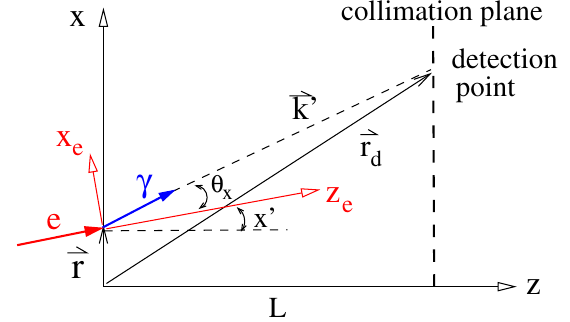
FIG. 9. Geometric constraint for a scattered gamma-ray pho- ton. The diagram only shows the projection of the constraint in the x - z